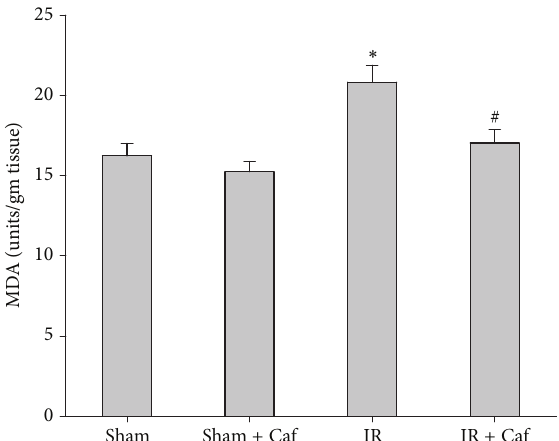
Figure 4: The pulmonary malondialdehyde (MDA) concentrations. Sham: the sham-operation group. Sham + Caf: the sham plus caffeine group. IR: the lower limb ischemia-reperfusion group. IR + Caf: the IR plus caffeine group. Rats of the Sham + Caf and the IR + Caf groups received caffeine (50mg/kg, intraperitoneal injection) immediately after reperfusion. To control for the effects of treatment vehicle, rats of the Sham and the IR group received normal saline (1.0mL, intra-peritoneal injection) at the comparable time point. One-way analysis of variance with the Bonferroni-Dunn test was used for multiple comparisons. The significance level was set at 0.05. Data were derived from 6 rats from each group and presented as mean ± standard deviation. ∗ 𝑃 < 0.05 : the IR group versus the Sham group. # 𝑃 < 0.05 : the IR + Caf group versus the IR